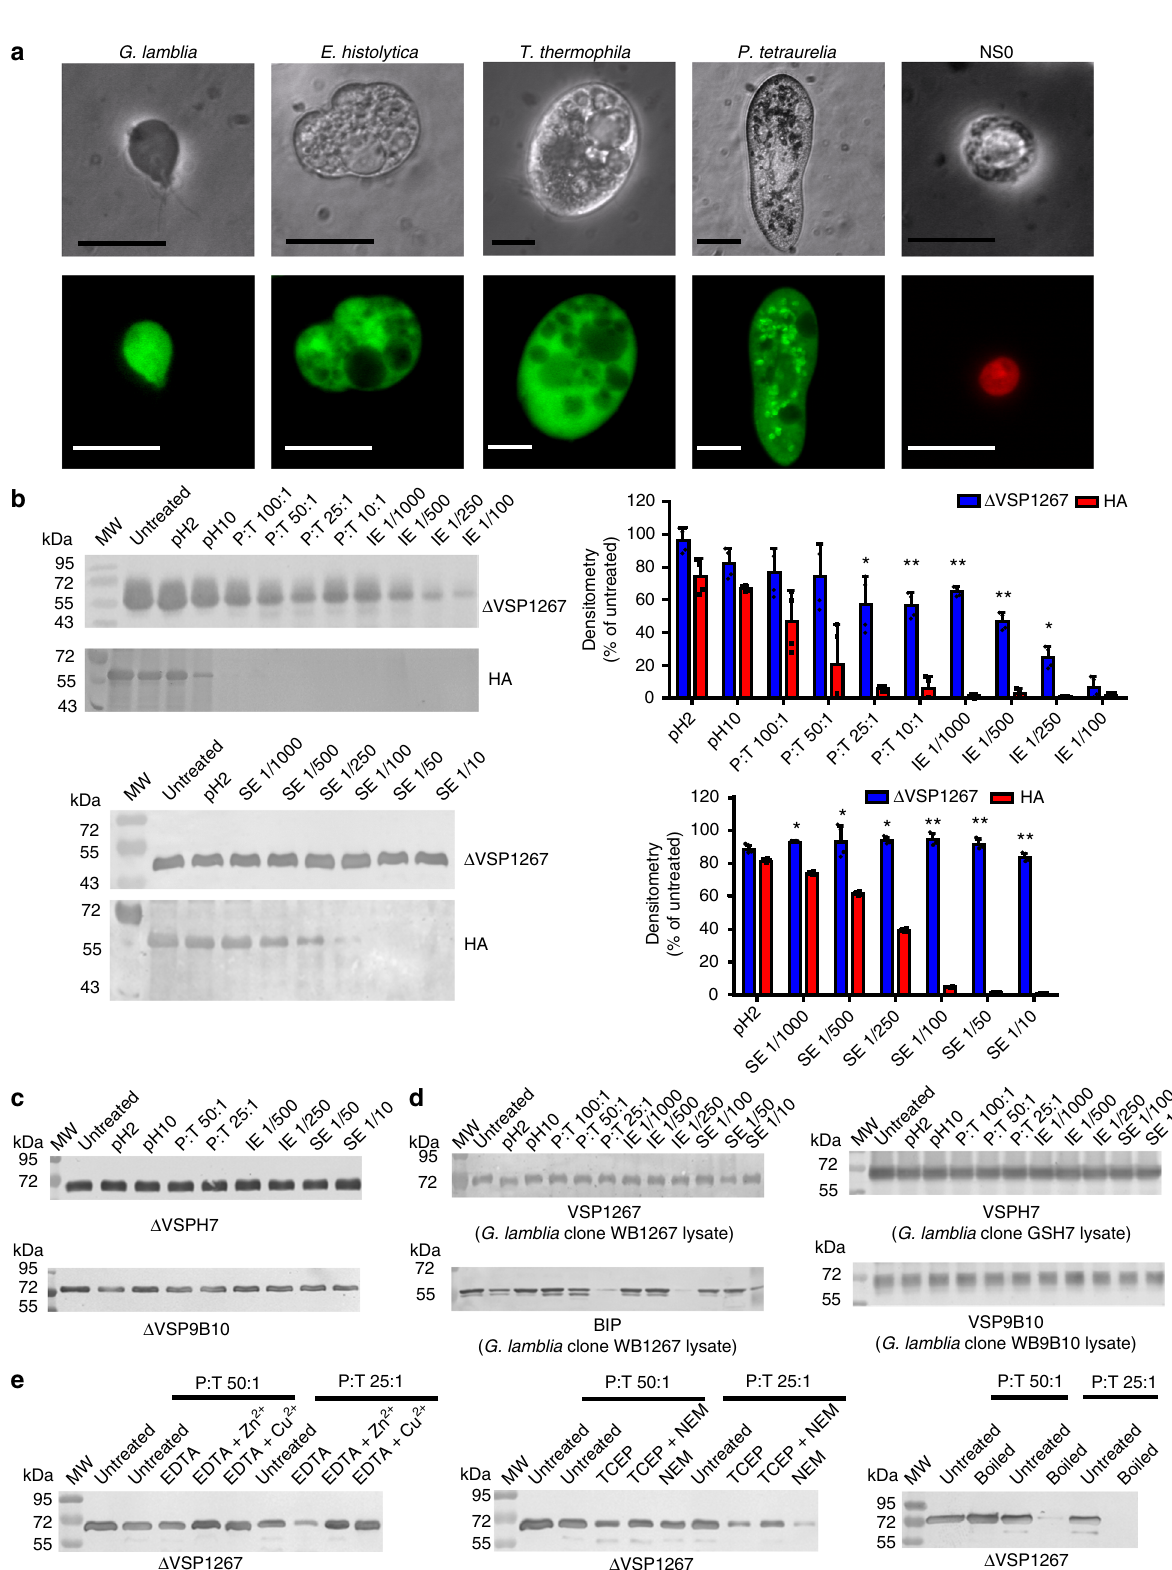
agents 30 . Using a panel of reporter HEK293 cells constitutively expressing human TLRs, Δ VSP1267 was able to signal through TLR-4 and, to a lesser extent, through TLR-2 (Fig. 2a). Additional studies using mouse receptors demonstrated that this activation was dose-dependent and quite speci fi c for TLR-4 (Fig. 2b).